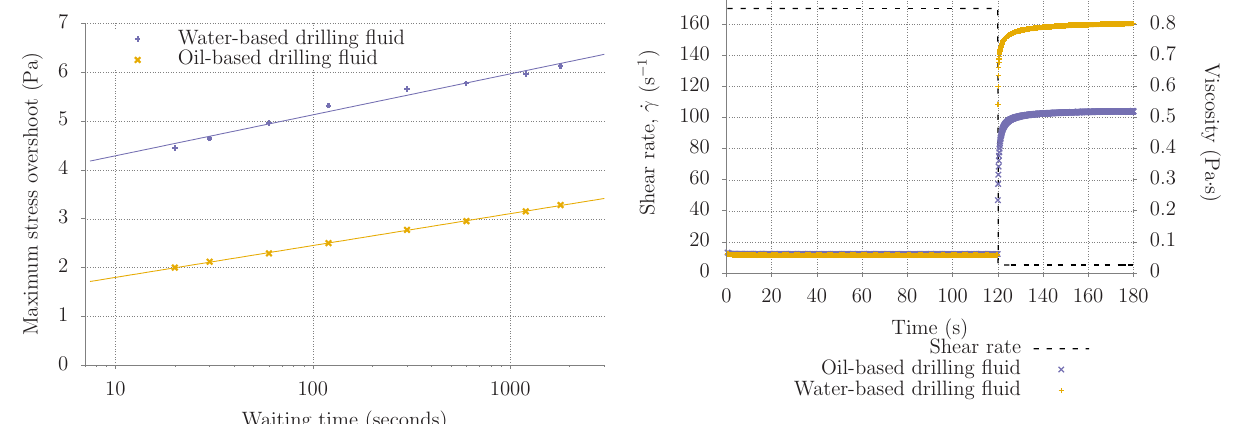
Figure 5: Example of stepping down sequences from a high to a lower shear rate. The black dotted line indicates the shear rate as function of time through the shear rate step sequence. The viscosity of the fluids, indicated by the purple and yellow markers, increases gradually toward the new steady state viscosity at the low shear